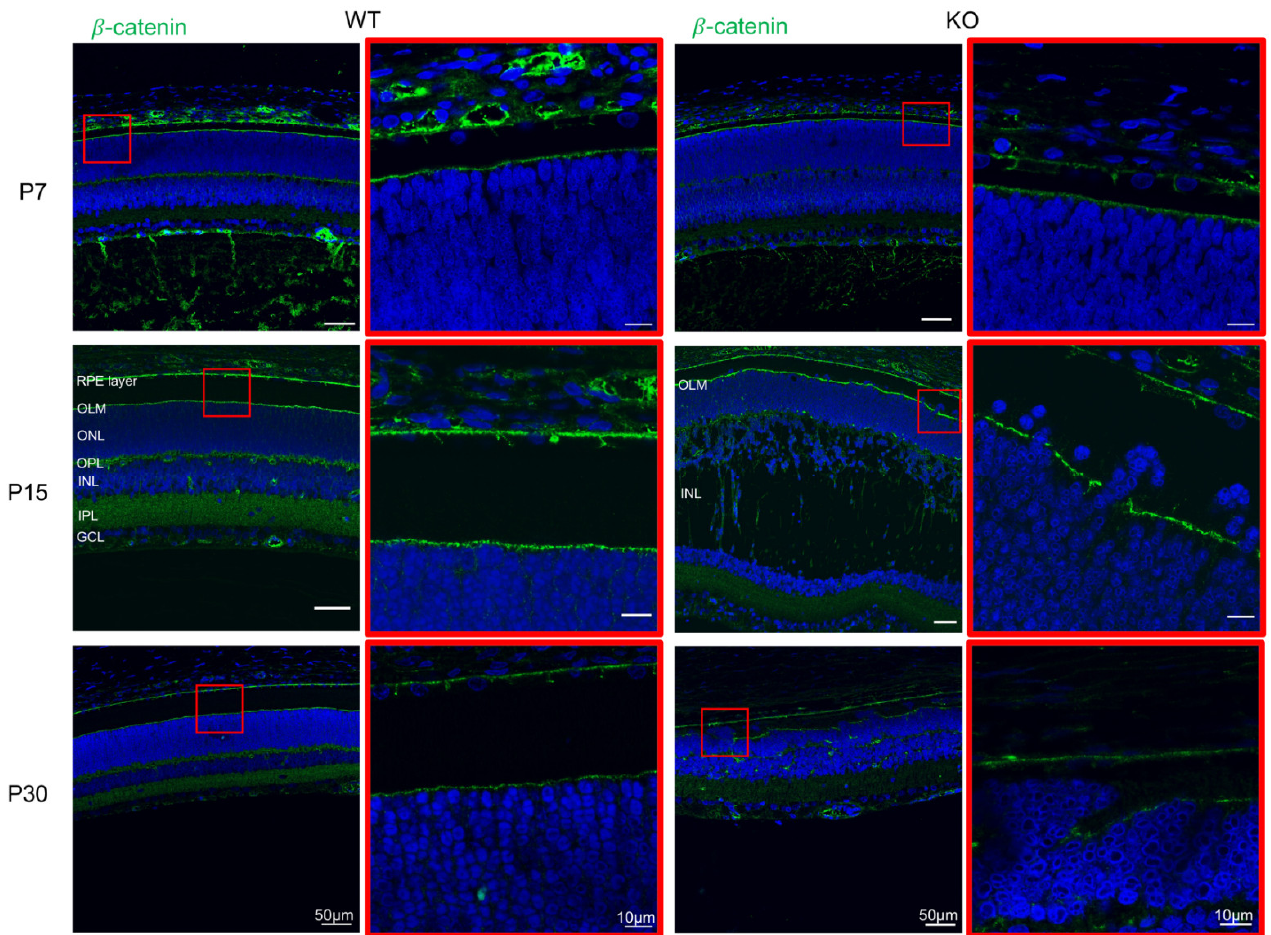
Figure 4. Disruption of outer limiting membrane (OLM) integrity in Rs1 -/Y rat retina. Immunostaining of WT and Rs1 -/Y (KO) rat retinas with β-catenin (green, OLM marker) at P7, P15 and P30. The images found on the right columns of WT and KO are a magnified portion of the image section encased in the red box in the left column. WT retinas showed a continuous outer limiting membrane (OLM) at all time points tested. In the KO retinas, the OLM also appeared continuous at P7. However, the initial presence of OLM breakdown was found at P15, and dislocated photoreceptors were found above the OLM at P15 and P30 in clusters of nuclei in the KO retinas.